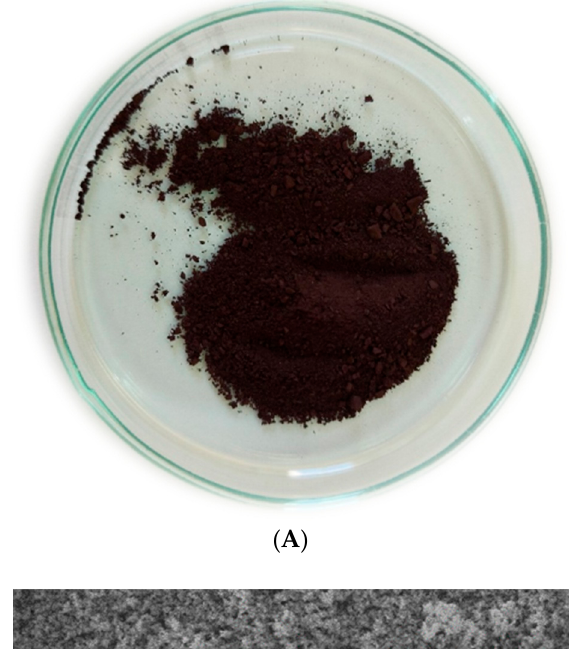
Figure 1. Characterizations of the solid product generated from the reaction of urea with CrCl 3 and FeCl 3 : ( A ); Color and shape of the product, ( B ); IR spectrum, ( C ); SEM image, and ( D ); EDX pro fi le.